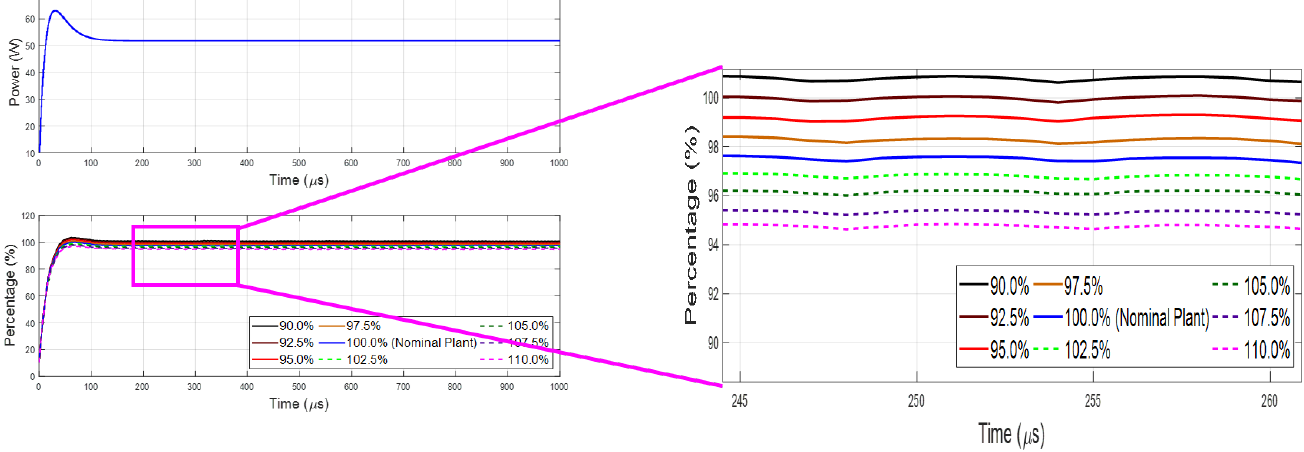
Figure 13. Performance of robust MPC.